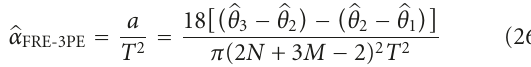
algorithm in the 2 P configuration, a simple estimator of α